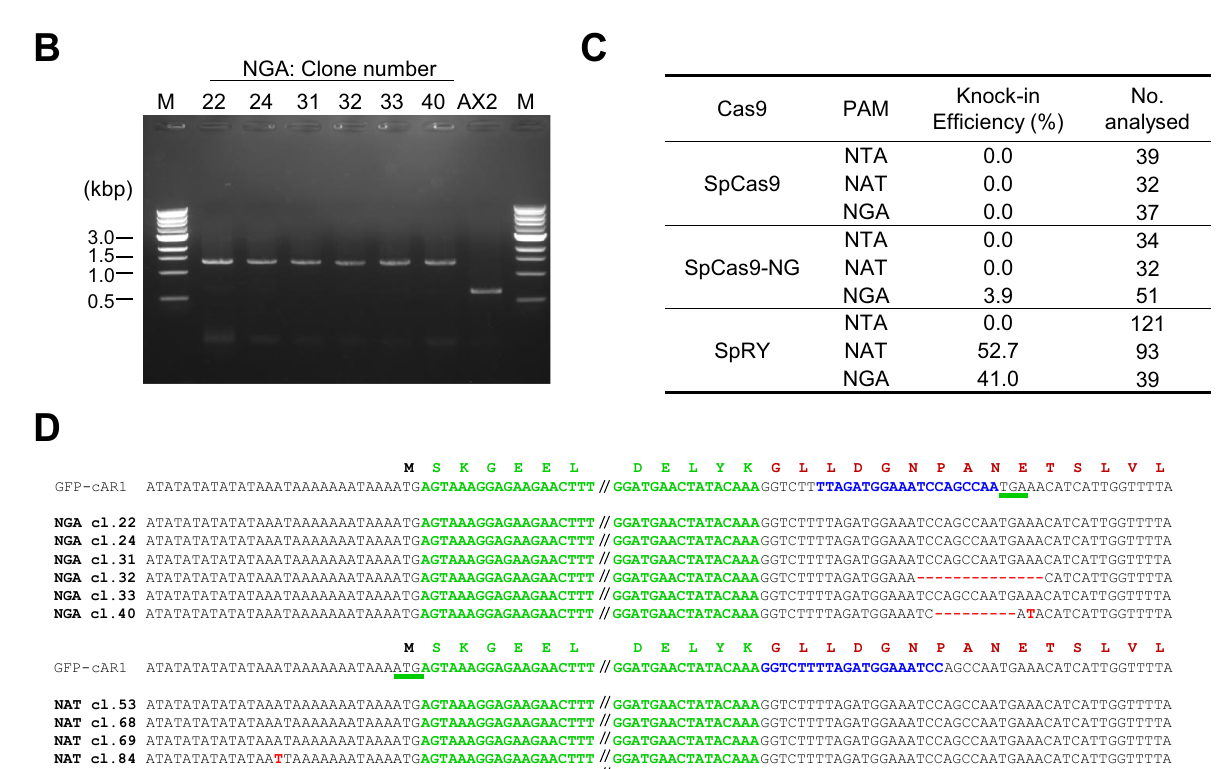
Figure 4. SpRY-mediated tag knock-in. ( A ) Schematic illustration of GFP knock-in at the cAR1 gene. Target sites in carA are in blue, and PAM sequences are underlined in green. Red arrowheads indicate sites of predicted cleavage by SpRY. Donor DNA was amplified by PCR using GFP primers flanked with homology arms (Table S4). ( B ) PCR amplification using primers flanking the knock-in site. AX2 presents the parental strain, and the rest of the lanes represent six individual mutants. An unprocessed image of gel shows that no other bands were present on the gel. ( C ) Summary of knock-in efficiencies with the indicated targets (NTA, NAT or NGA PAMs). ( D ) Sequencing results from the knock-in region. Sequences of GFP-cAR1 (top) and individual PCR positive mutants are shown. GFP sequences are in green, and target sequences are in blue. PAM sequences are underlined in